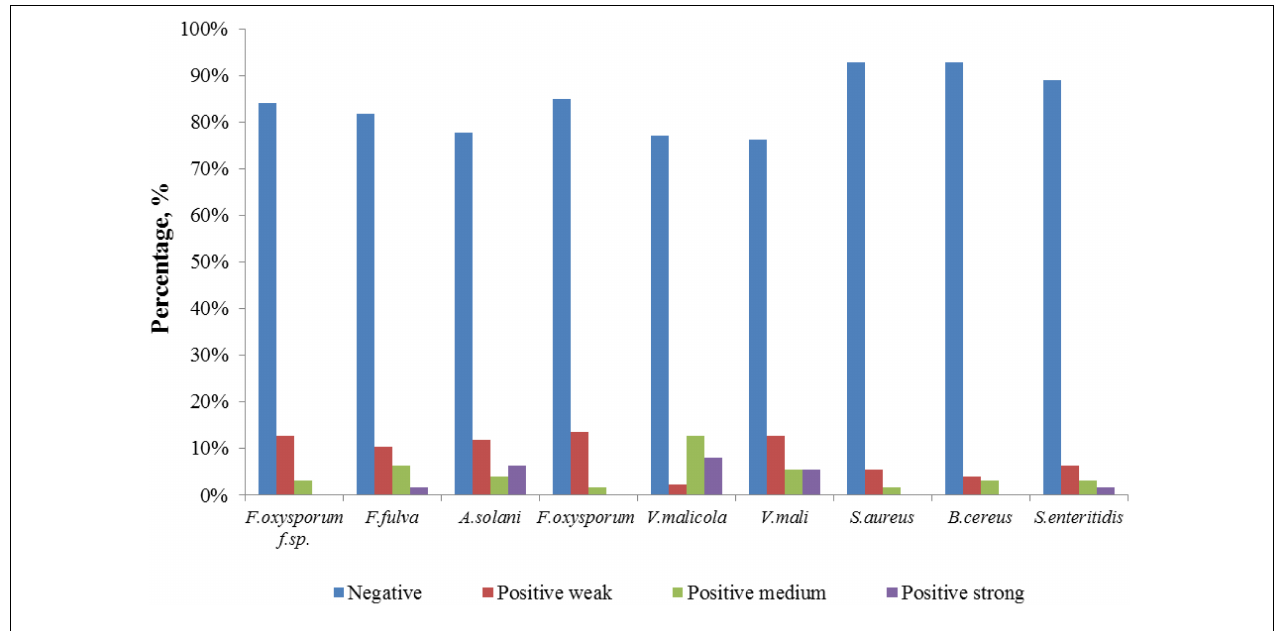
FIGURE 6 | Distribution of positive strains tested for antimicrobial